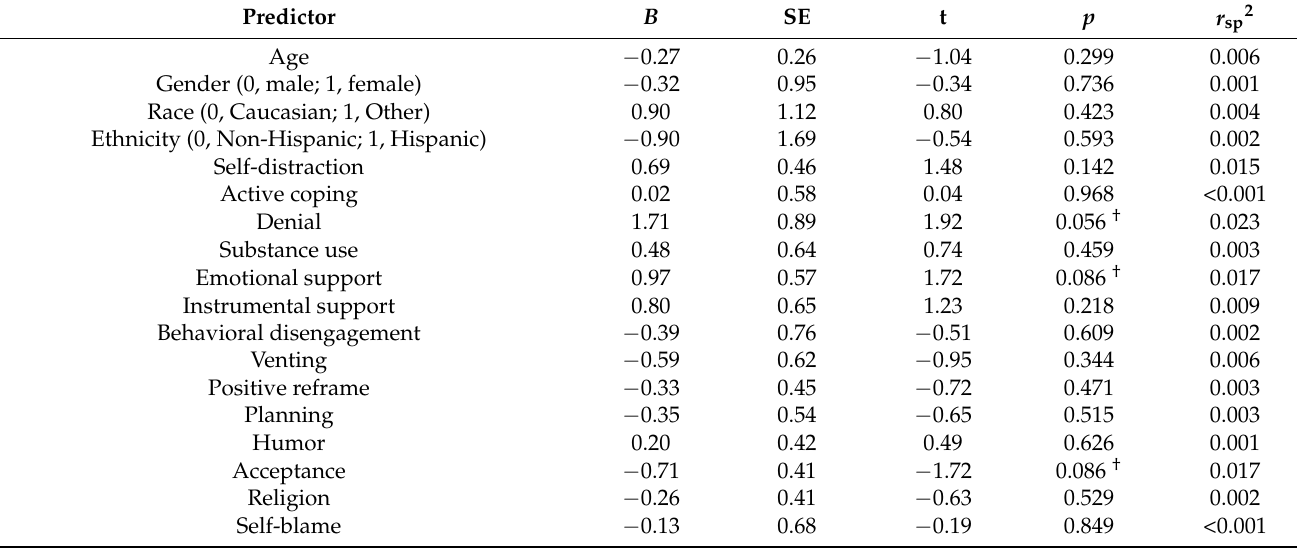
Table 3. Hierarchical multiple linear regression analysis results of coping styles predicting fear of COVID-19.